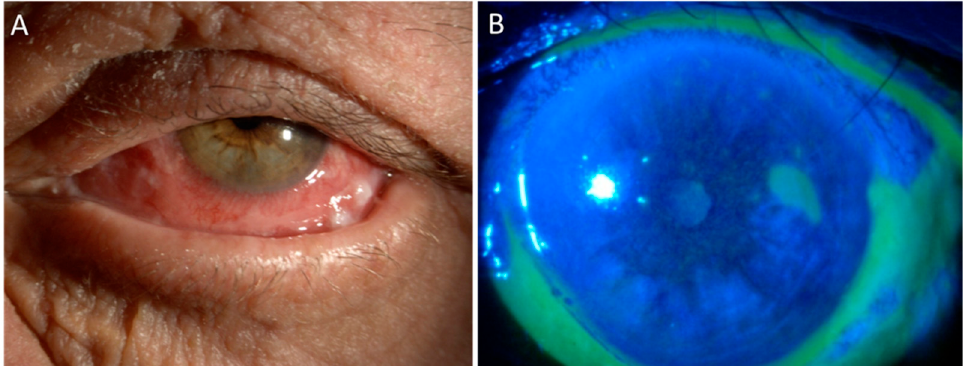
Figure 2. Toxic blepharoconjunctivitis following MMC. An 80 year-old man affected by relapsing squamous cell carcinoma of the lower fornix in his left eye, who had been treated elsewhere by repeated surgical excisions, presented to our Center after 15 days of continuous treatment with MMC 0.04% QID, with (Part A ) severe orbital swelling, erythematous-desquamative blepharitis, and (Part B ) corneal epithelial defect and diffuse conjunctival melting with pseudomembranes.